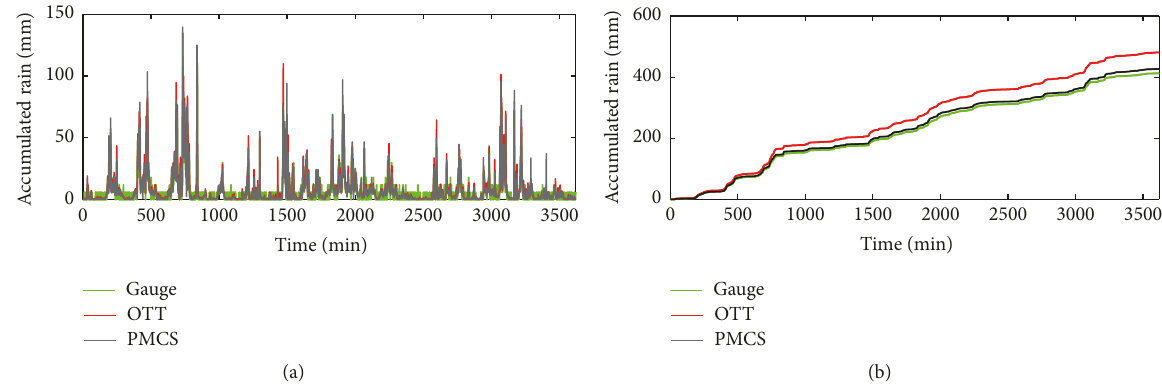
Figure 19: Comparison of the rain intensities and accumulated rainfalls measured from PMCS, OTT, and Gauge.